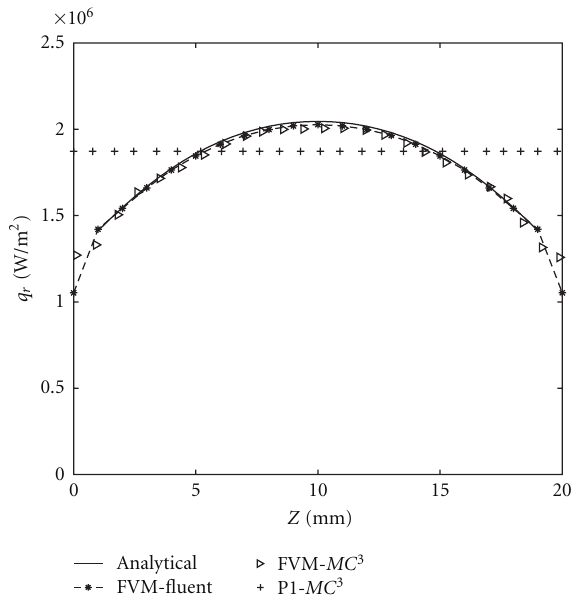
Figure 8: Test case III. Incident radiative flux for a transparent